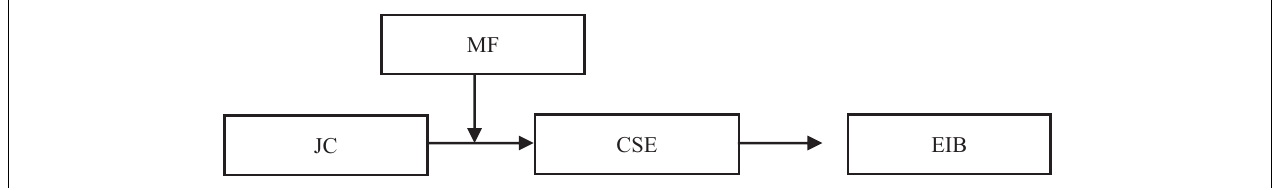
FIGURE 1 | The proposed conceptual model. JC, job control, MF, mindfulness, CSE, creative self-efficacy, EIB, employee innovative behavior. TABLE 1 | Respondents’ summary.